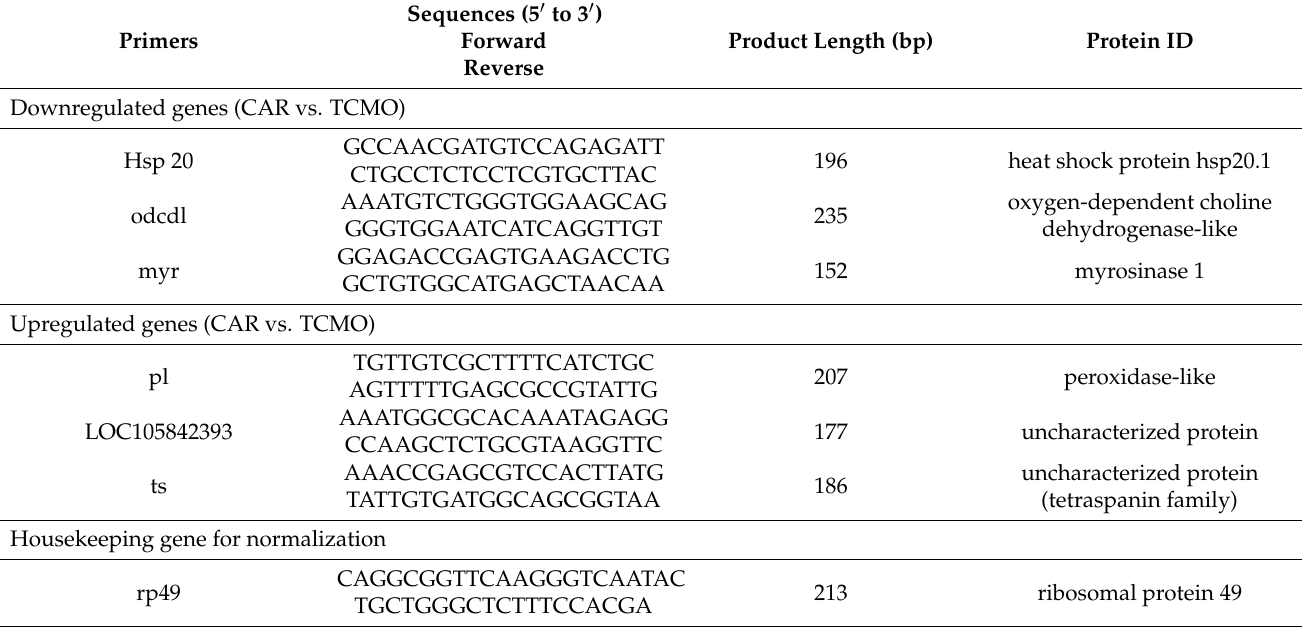
Table 1. Primers used for qPCR validation of differentially expressed genes in Bombyx mori